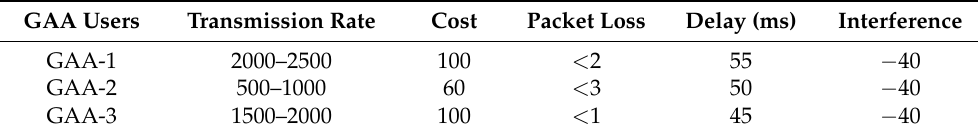
Table 8. GAA users’ classification and their QoS